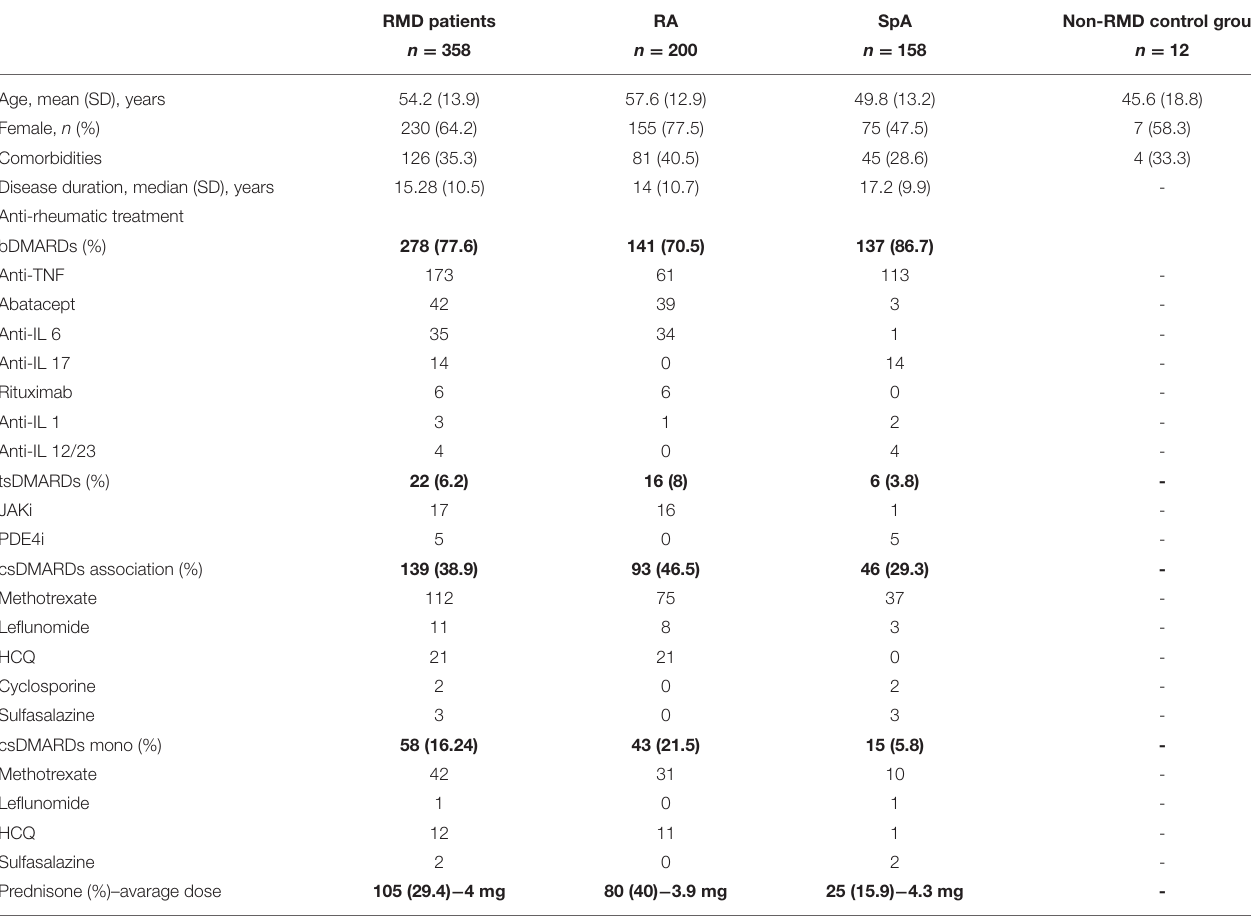
TABLE 1 | Characteristics of the study